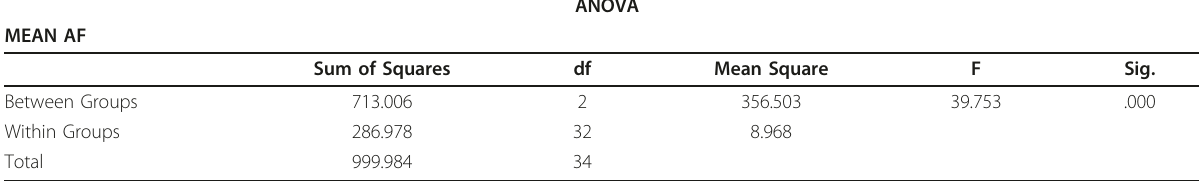
Table 3 ANOVA for MCM2 MEAN AF